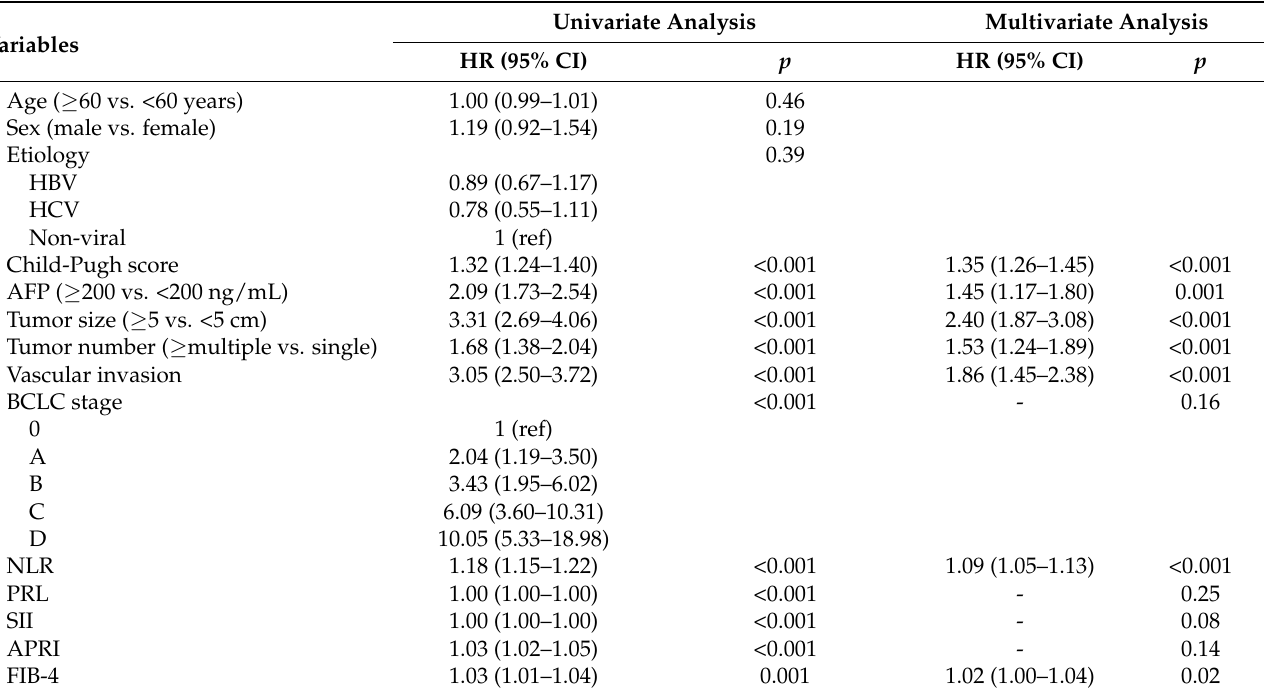
Table 3. Univariate and multivariate analyses of factors associated with survival. Univariate Analysis Multivariate